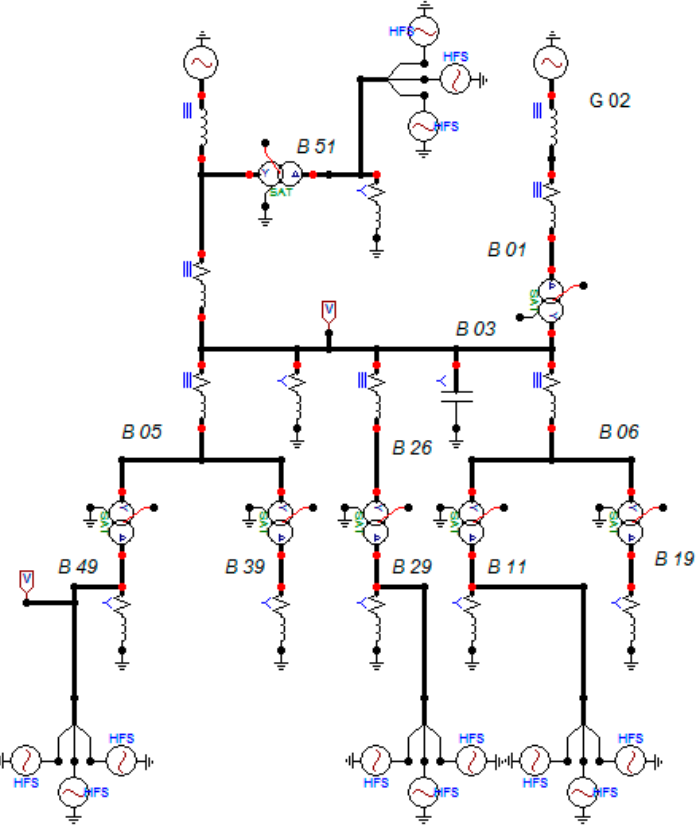
Figure 4. IEEE 13-bus industrial distribution electrical system ATPDraw diagram, adapted from [27]. Database Creation